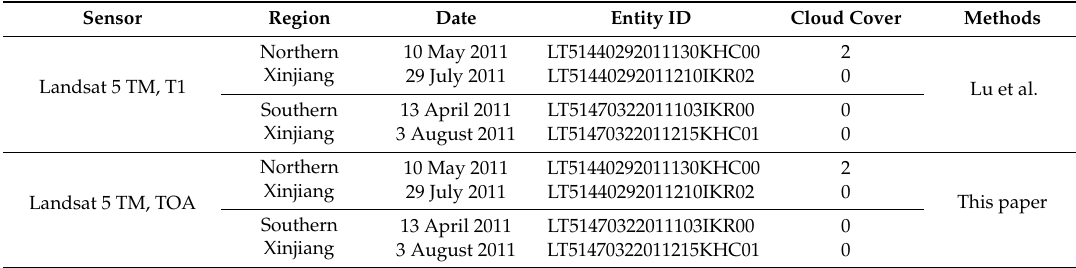
Table 8. Landsat-5 TM data source parameters in each